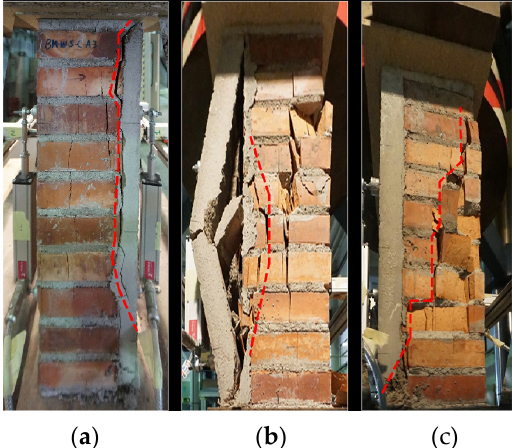
Figure 9. Side view of the sample after failure ( a ) Mode I; ( b ) Mode II; ( c ) Mode III. Mode I: progressive damage occurs at the top and bottom of the interface during loading, and cracks appear on the non-sprayed side of the brick wall, with these cracks mainly concentrated in the upper half. During load peaks, the sprayed layer separates on the brick close to the interface, and the sample loses its load-bearing capacity. Mode II: during loading, progressive damage occurs at the top and bottom of the interface. The bricks appear damaged on the side without being sprayed and closed to the interface